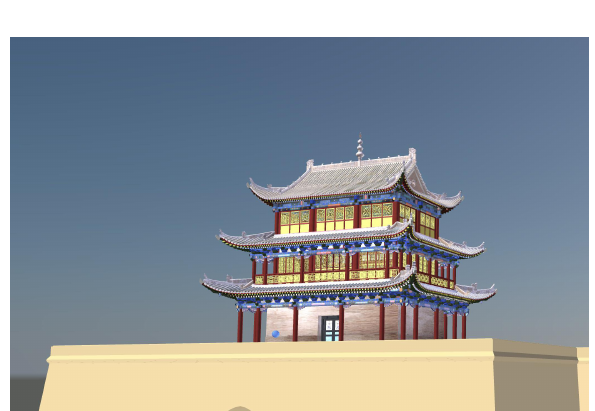
Figure 24. Presentation HBIM model in